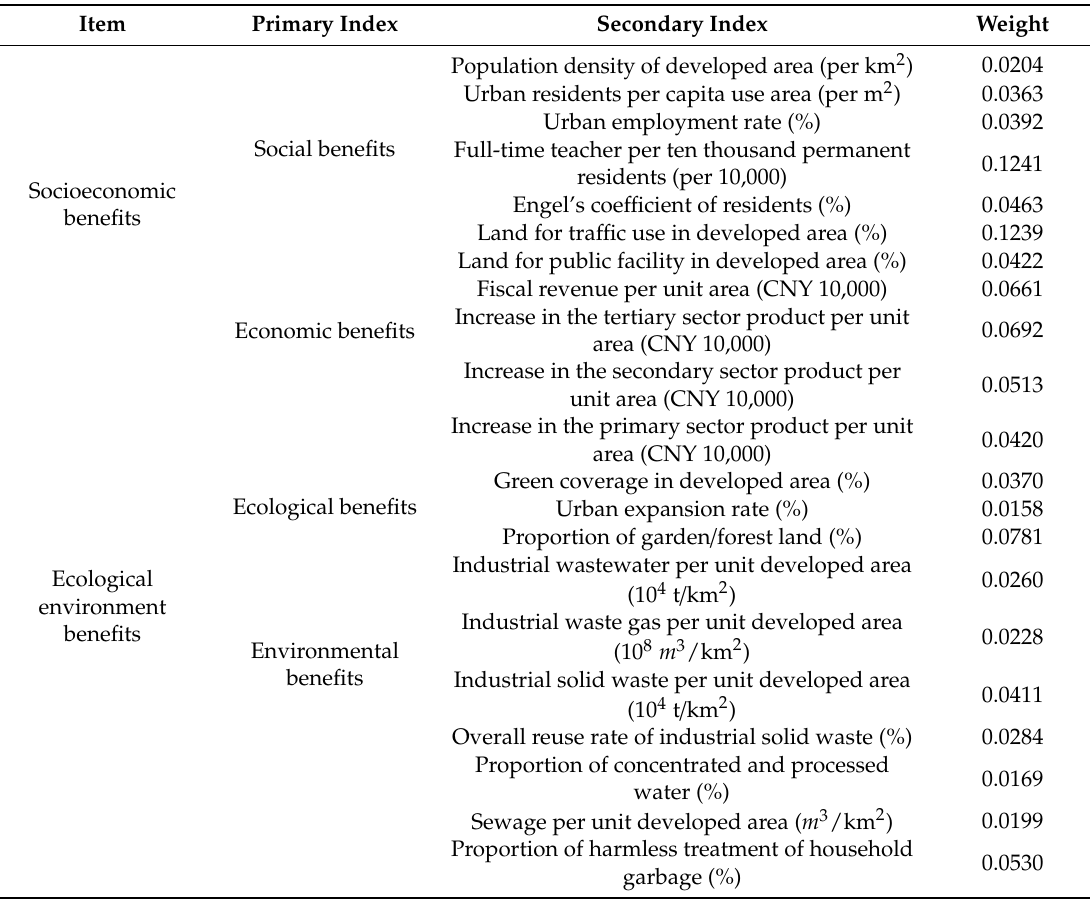
Table 1. The evaluation index system of land use